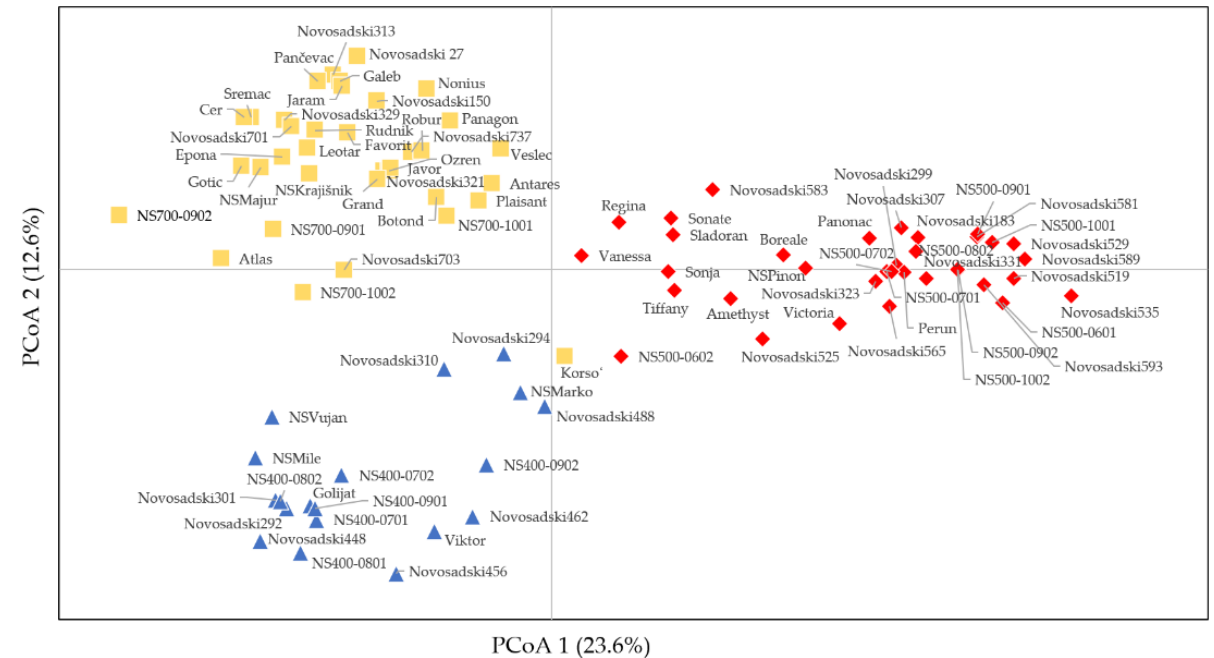
Figure 2. Principal coordinate analysis of 90 barley genotypes based on microsatellite data. Red diamond—winter two-rowed barley; yellow square—winter six-rowed barley; blue triangle—spring two-rowed